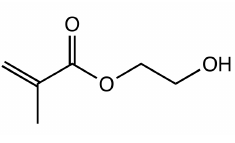
Figure 7. Chemical Structure of resin monomer. Hydroxyethyl methacrylate (HEMA).